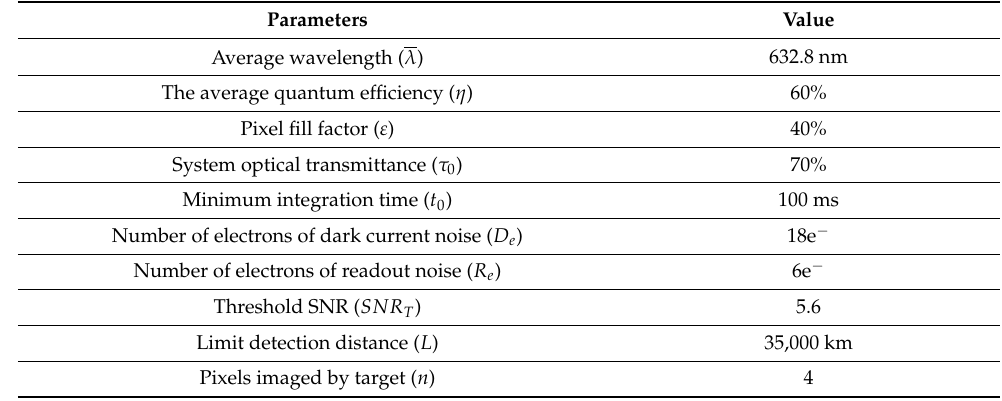
Table 2. Values of parameters of the SBV